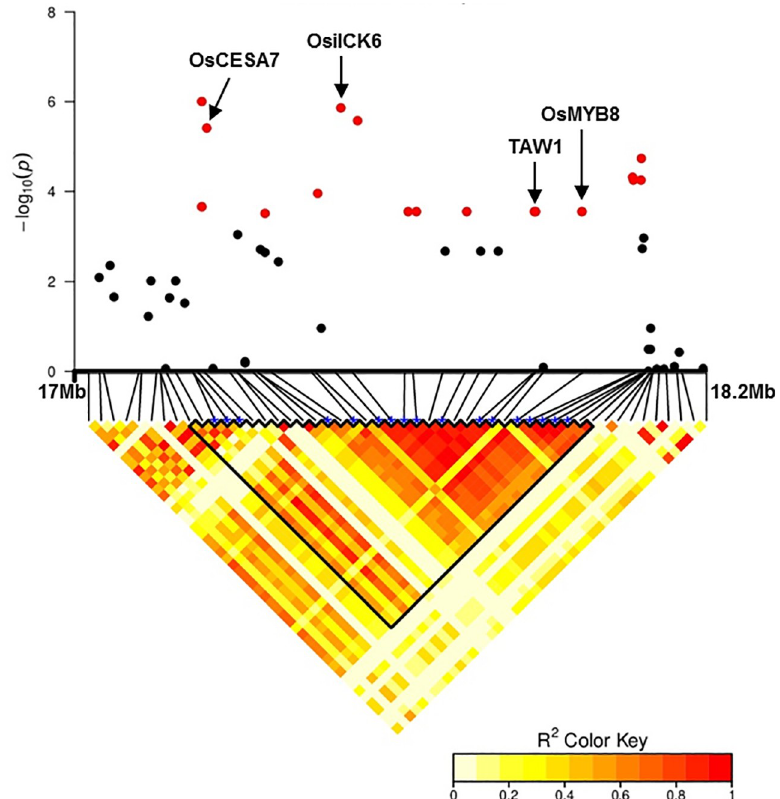
Fig 3. Genomic region of QTL_11 for leaf fresh weight in the full panel, shown in a Manhattan plot and linkage disequilibrium (LD) heat map. In the Manhattan plot, significant SNPs are highlighted in red, and candidate genes of interest are also illustrated. The genomic region of QTL_11 is specified in the boundary area in the LD heat